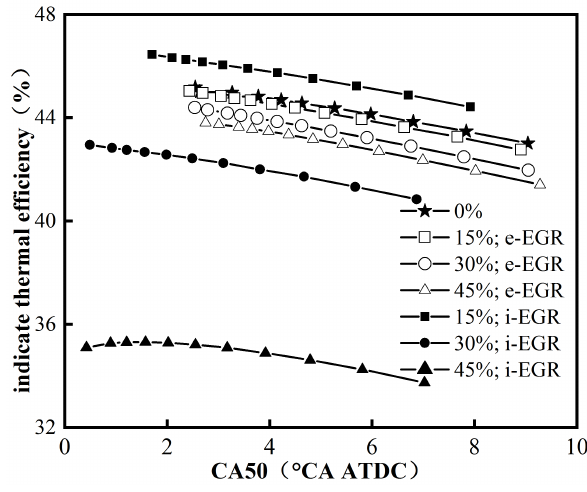
Fig. 8 Effects of CA50 and EGR ratio on indicated thermal efficiency.